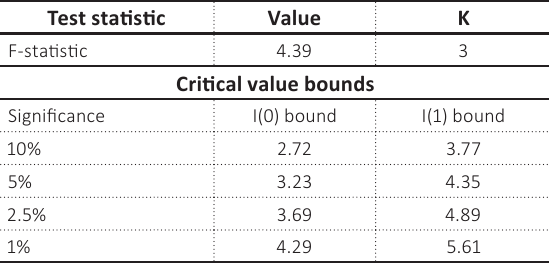
Table 3. ARDL bounds test for liquid liabilities and growth finance indicators